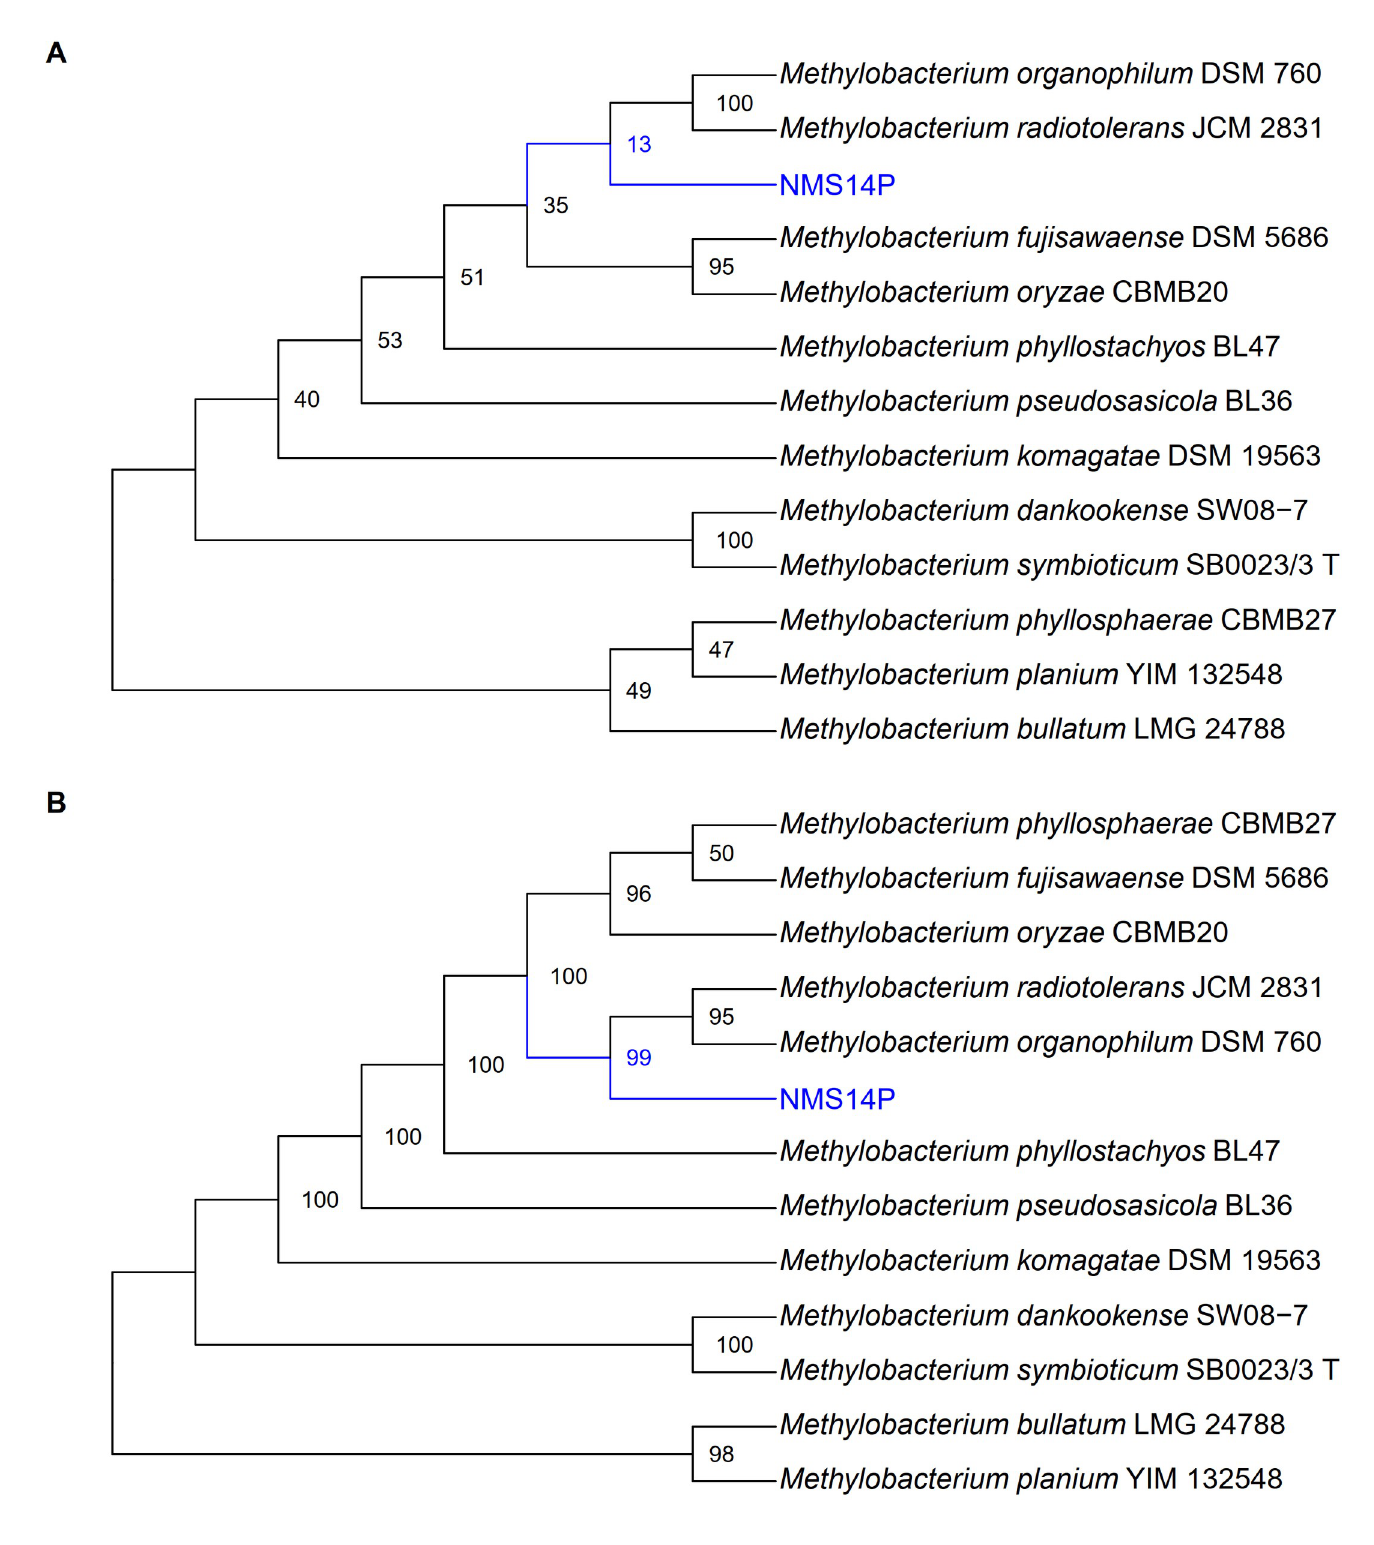
PLOS ONE | https://doi.org/10.1371/journal.pone.0281505 February 7,